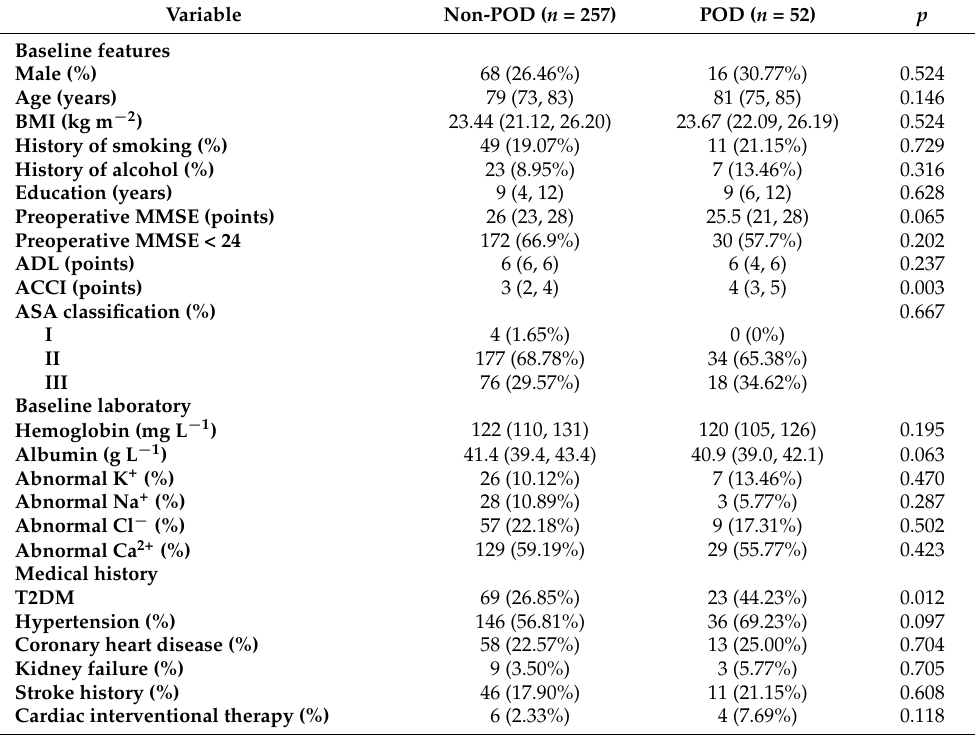
Figure 1. Study flow chart. Table 1. Baseline features and preoperative characteristics.